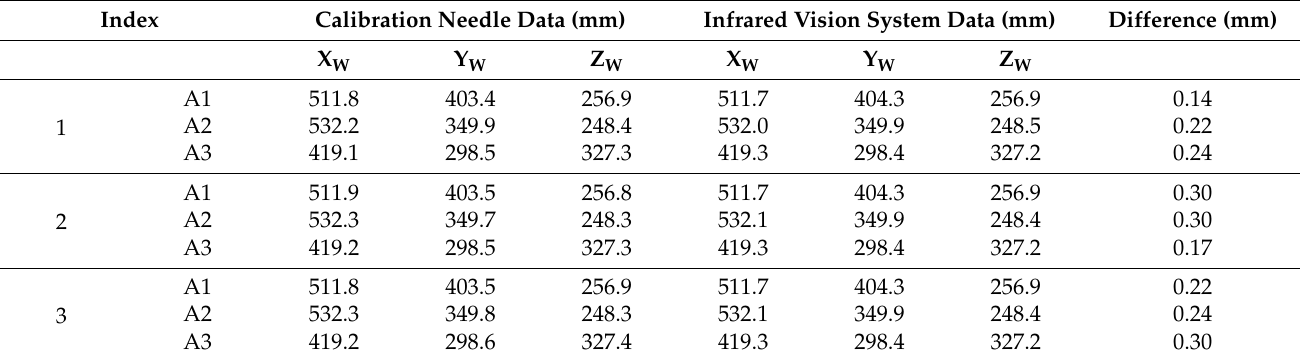
Table 2. Position measurement results of two methods.